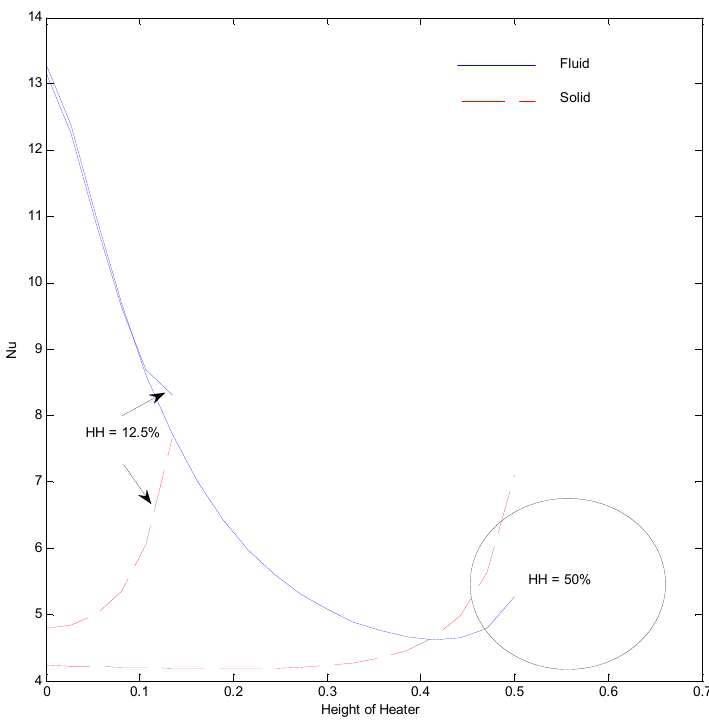
Mathematics 2019 , 7 , 1085 Figure 14. Nusselt number at Ra = 100, H = 5, Kr = 1, Rd = 0 for strip at x = 0.25. Figure 14. Nusselt number at Ra = 100 , H = 5 , Kr = 1 , Rd = 0 for strip at 25.0